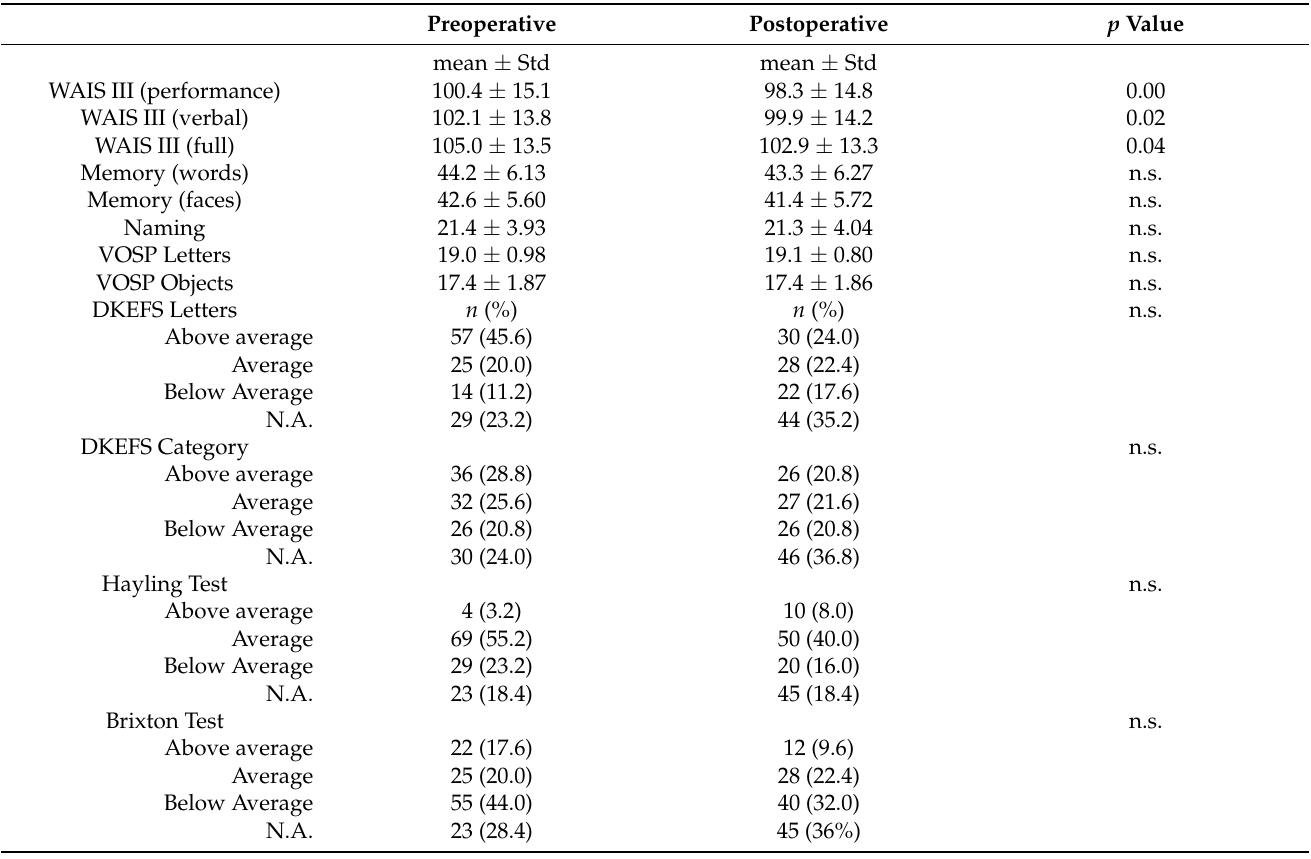
Table 2. Pre- and Postoperative Neuropsychological Assessments. Preoperative Postoperative